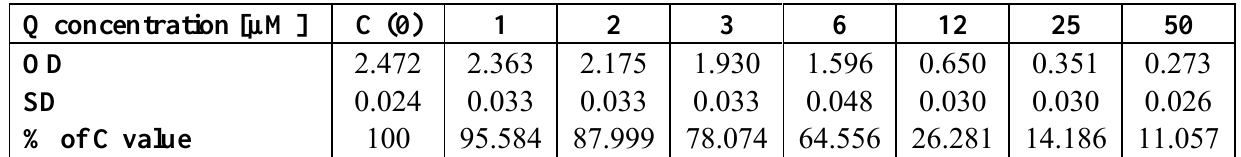
Table 1. Cytotoxic effect of Q on cells in DB-sensitive line as related to concentration of the drug after 72 h; p < 0.001 for optical density (OD) of C vs . all. C—Control.